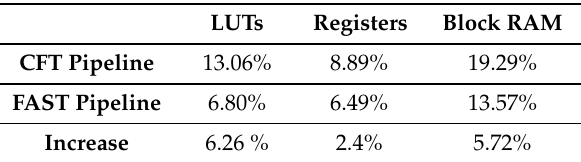
Table 4. The Comparison of the CFT Reconfigurable Pipeline and the FAST Five-stage Pipeline in Resource